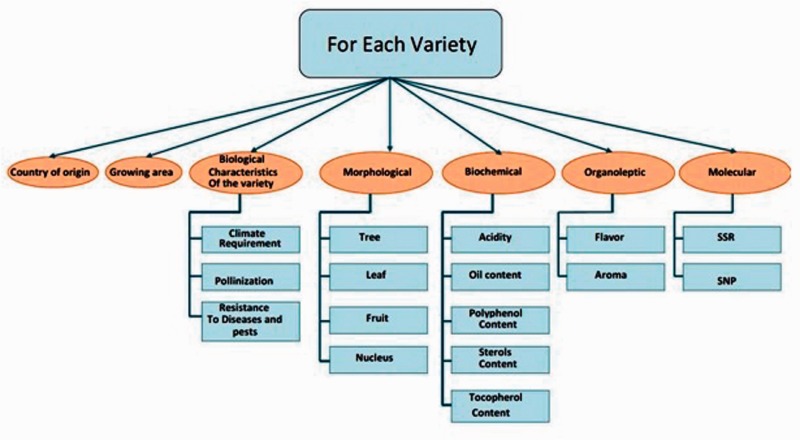
Data classification.